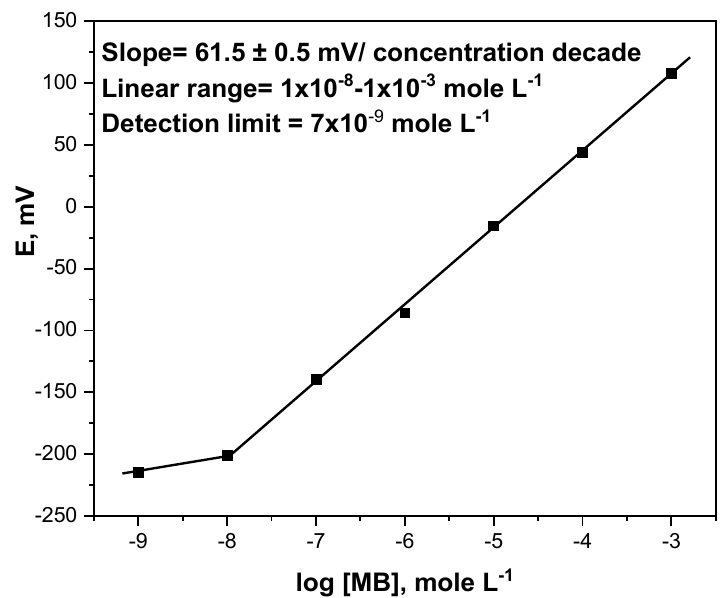
Figure 2. Potentiometric calibration plot of the MIP-based MB microchip.